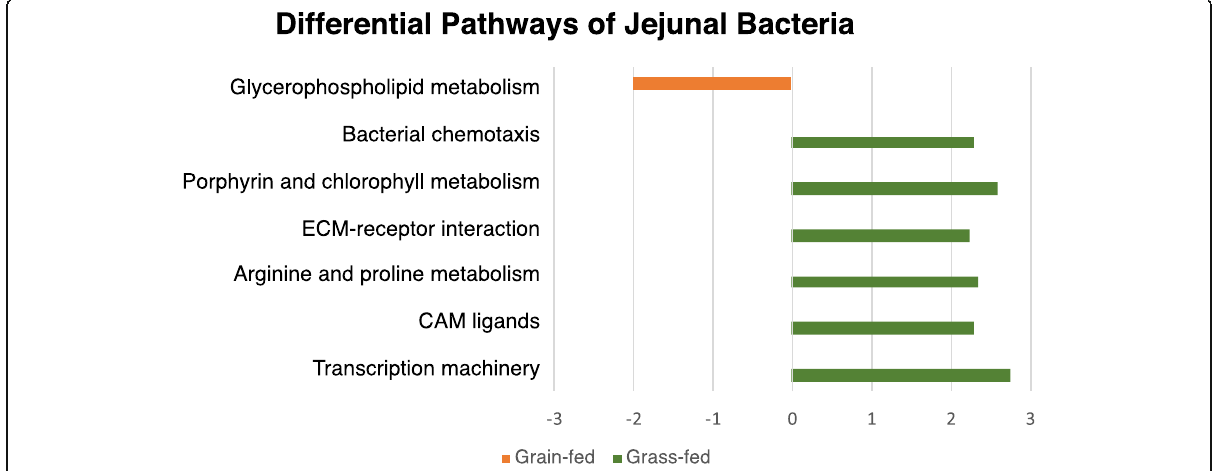
Fig. 7 Predicted KEGG pathways significantly impacted by the diet in jejunal bacterial communities in Angus beef cattle (LDA score ≥